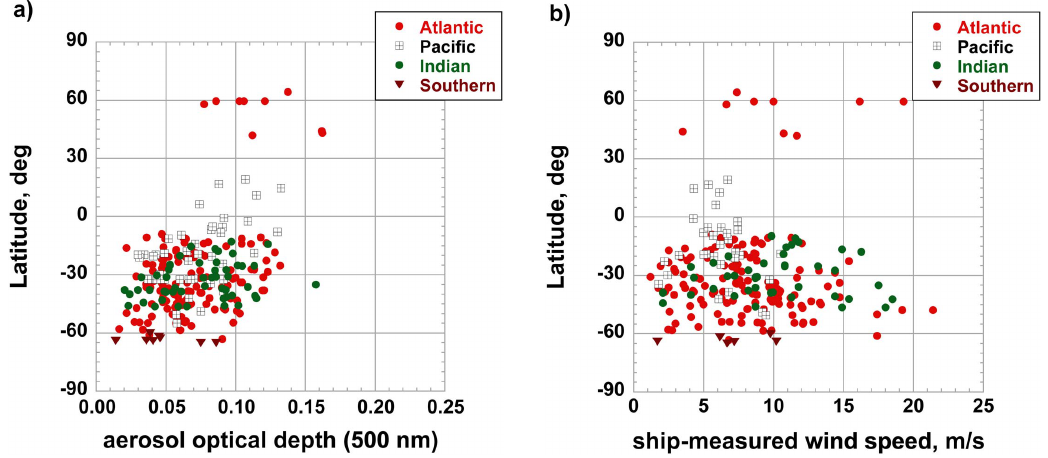
Fig. 2. Latitudinal dependence of AOD daily averages used in this study (a) , and latitudinal dependence of corresponding daily averaged ship-based wind speed (b) .